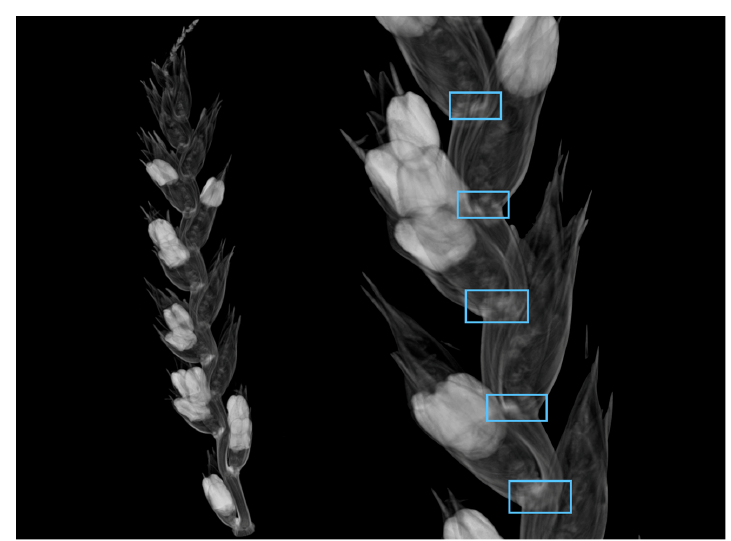
Figure 11. Detected grains and stem nodes. Stem nodes have similar intensity with grains, while stem nodes and grains are spatially close.